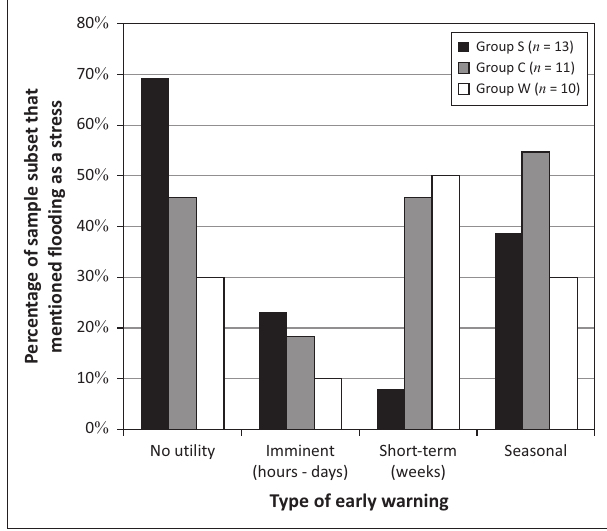
FIGURE 13: Answers of those who were asked what kinds of early warning would be useful, displayed by group.